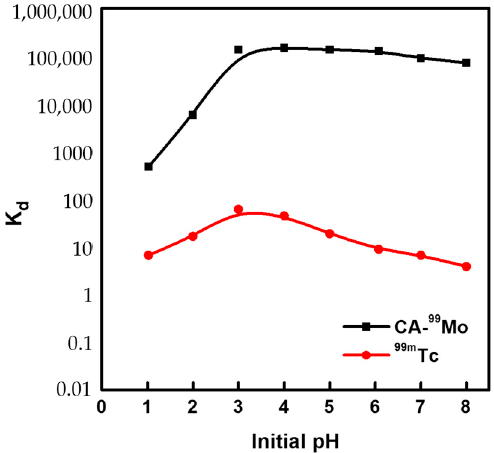
Figure 4. Distribution ratios (K d ) of CA- 99 Mo and 99m Tc on mesoporous alumina (SA-517747).